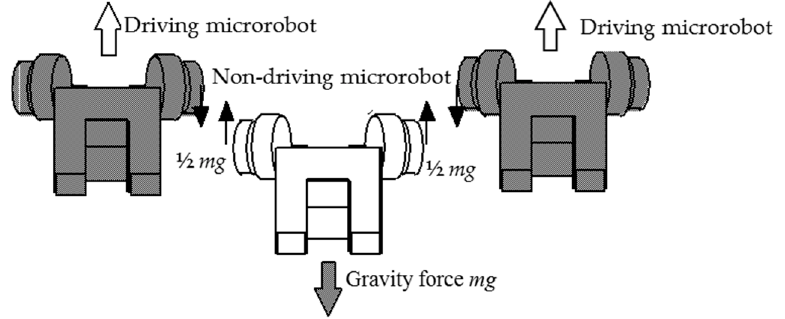
Figure 15. Image of non-driving microrobot pulled up by driving microrobot. m g is the gravity force.